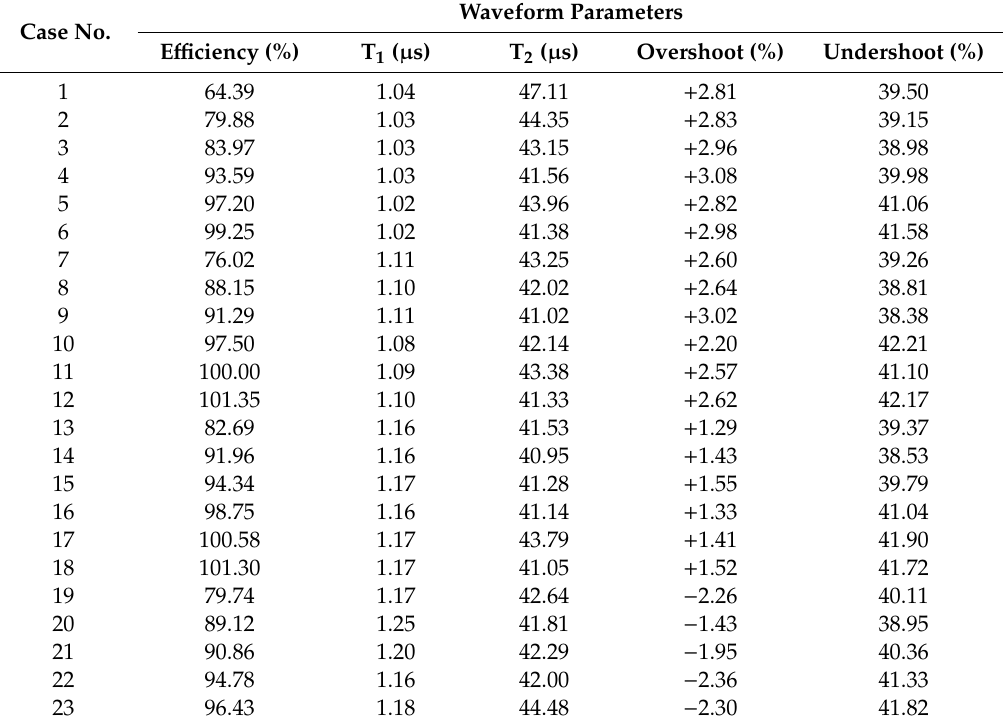
Table 5. The generated waveform parameters associated with the cases in Table 4. Case